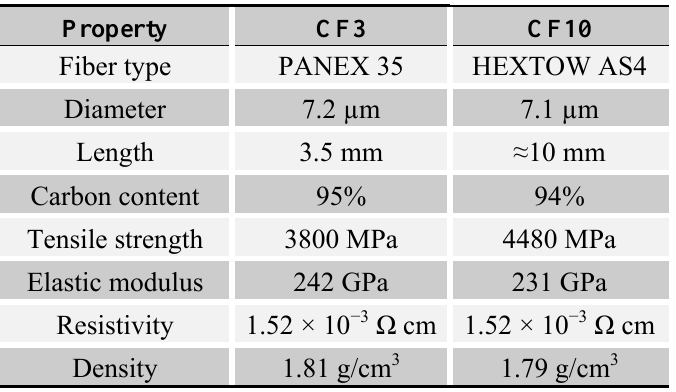
Table 2. Carbon fiber (CF)